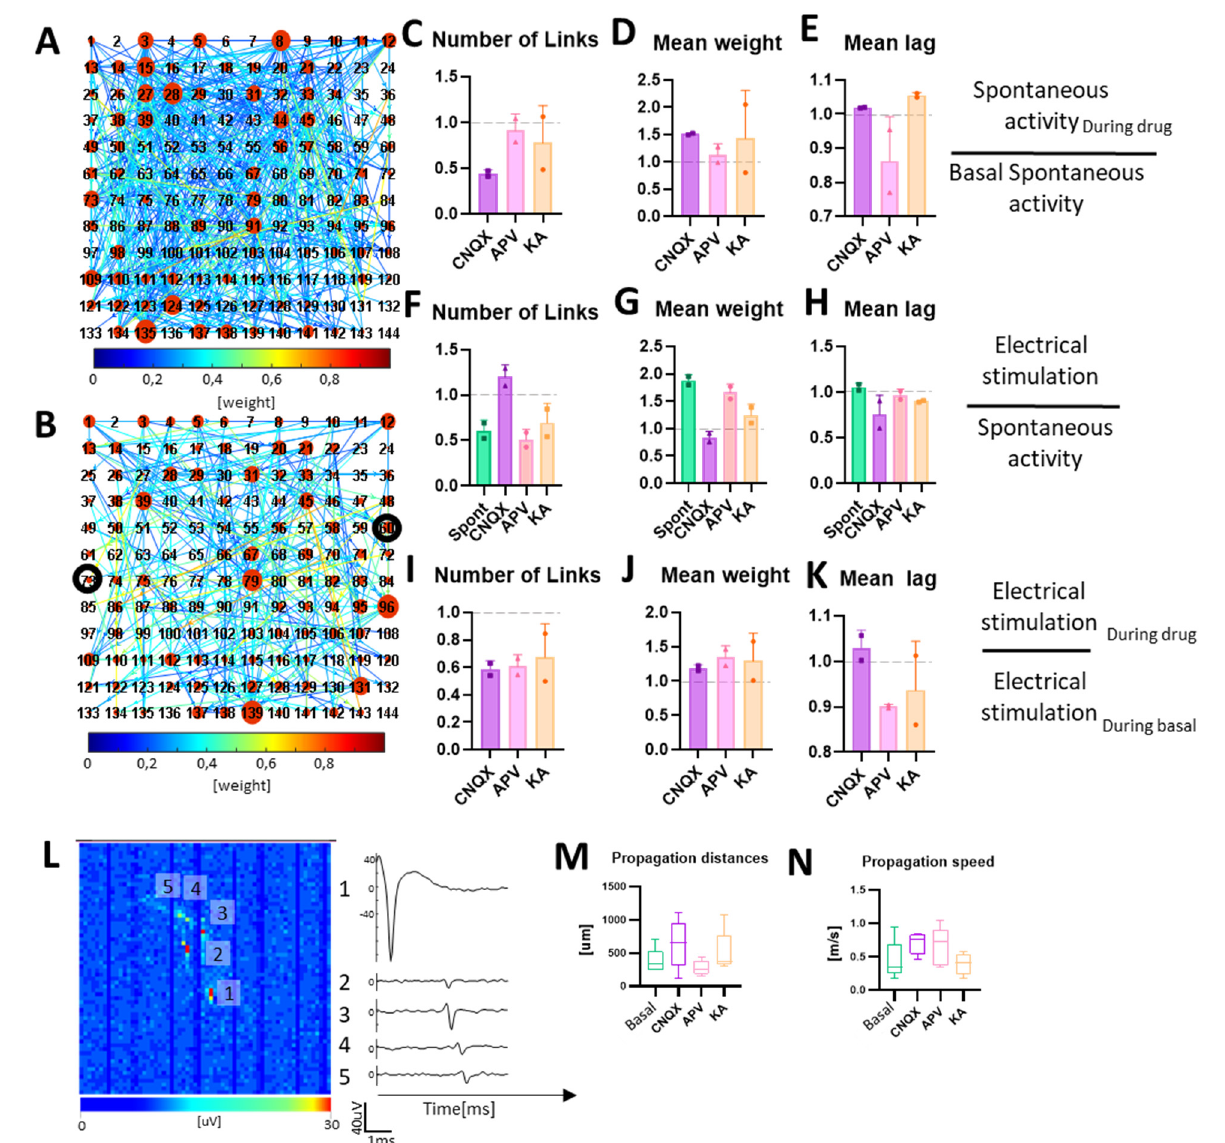
Figure 6. Neuronal connectivity in neurospheroids. ( A , B ) Connectivity matrix obtained from a neurospheroid grown on HD-MEAs at DIV 57 during ( A ) spontaneous basal activity and ( B ) electrical stimulation. Each red circle represents an electrode; the larger the size of the red circle the greater the number of links. Colormap represents the weight of each link. The darker circle indicates electrodes used for delivering stimulation. We restricted the connectivity analysis to 144 electrodes arranged in a 12 × 12 square grid, placed under the neurospheroids. ( C – E ) Graphs showing the effect of neuromodulators on connectivity, in particular: ( C ) the number of links, ( D ) mean weight, and ( E ) mean lag, evaluated on 10 min of activity under the effects of the drugs and normalized on 10 min of spontaneous electrical activity without drug. ( F – H ) Graphs showing the e ff ect of electrical stimulation during the neuromodulation on connectivity, in particular: ( F ) the number of links, ( G ) mean weight, and ( H ) mean lag, evaluated on 10 min of recording during electrical stimulation under the e ff ects of the drugs (or no drug for electrical stimulation, labelled as basal) and normalized with data obtained from the recording of spontaneous activity in the same conditions. ( I – K ) Graphs show the overall e ff ect on connectivity of the electrical stimulation during neuromodulation, in particular: ( I ) the number of links, ( J ) mean weight, and ( K ) mean lag, evaluated during the electrical stimulation under the e ff ect of the neuromodulator, normalized by the data obtained from recording during electrical stimulation without drugs. Bars represent the mean value, dots represent single experiments, and errors are expressed using standard deviation. ( L ) On the left, the activity map of the HD-MEAs, showing the averaged axonal propagation of a single neuron. The image is